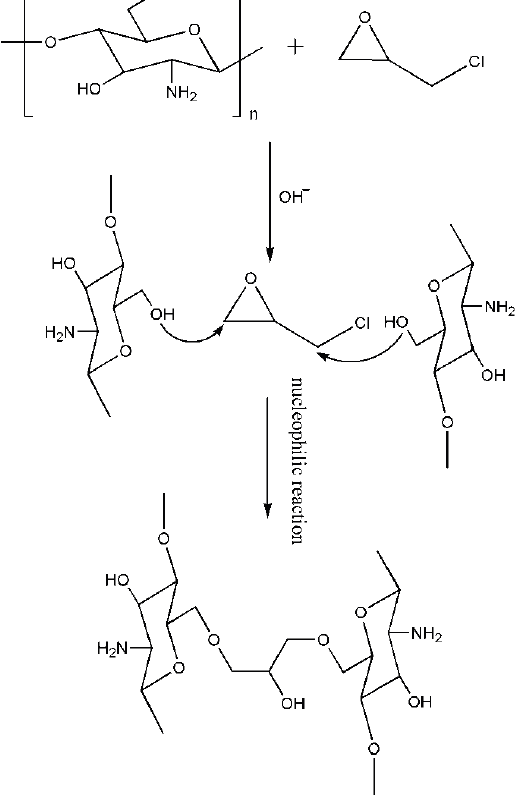
Figure 4. Cross-linking mechanism of chitosan and ECH under alkaline